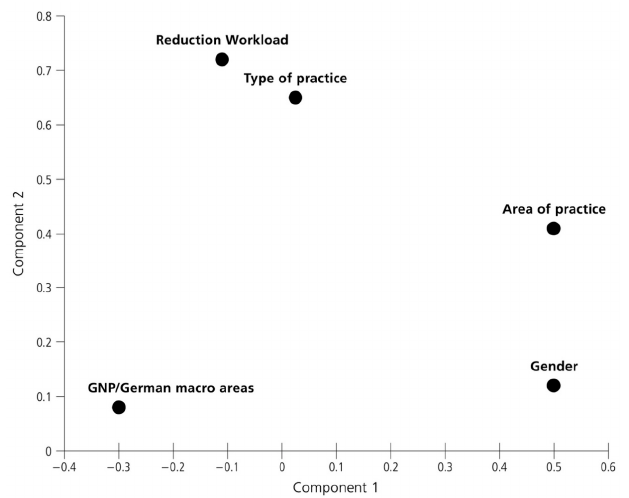
Figure 2. Orthogonal Rotation (varimax) of the first two principal coordinates in the total sample, the percentage of reduction of the weekly workload during the lockdown period, and the type of practice tend to form a separate cluster with a high goodness of fit (65.64%).